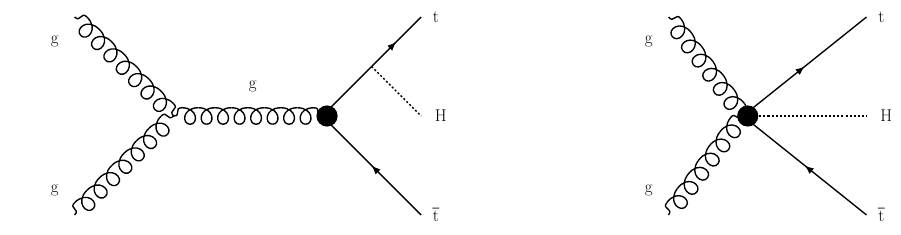
operator. This u G